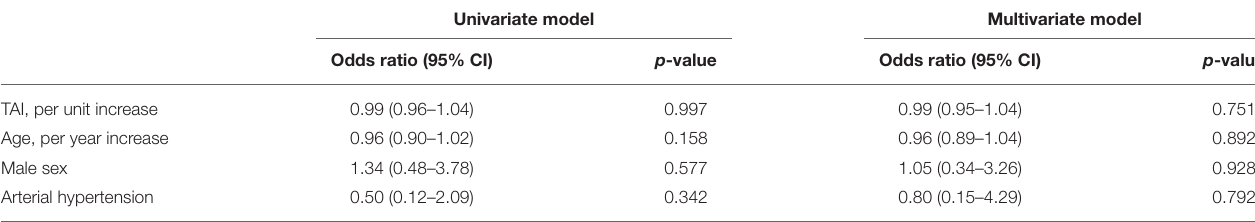
TABLE 2 | Binary logistic regression analysis for the distinction of cardioembolic stroke from large artery atherosclerosis